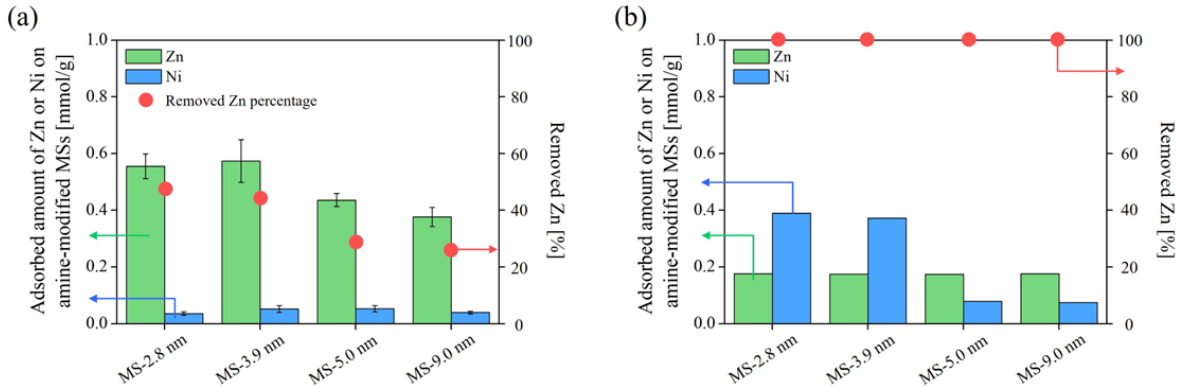
Figure 10. Adsorption amount of Zn and Ni on amine-modified MS with different initial MS pore sizes in Zn–Ni binary system. Concentration of each element is Zn/Ni = 1.5/1.5 mmol/L ( a ) and Zn/Ni = 0.2/1.5 mol/L ( b ).